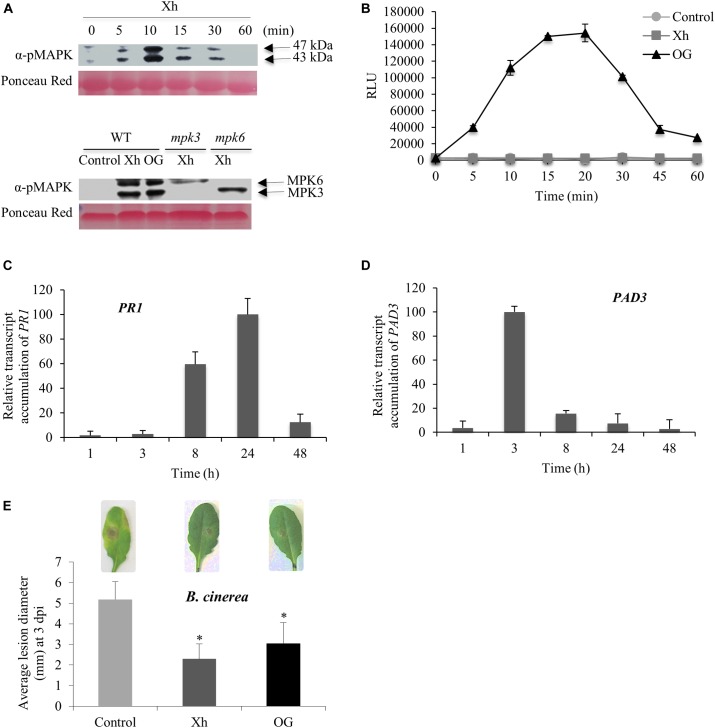
Immune responses and resistance against B. cinerea induced by Xh or OG in Arabidopsis. (A) Upper lane: phosphorylation of two mitogen-activated protein kinases (MAPKs) in Col-0 plants treated by Xh (1 mg/ml) detected by immunoblotting with α-pERK1/2. Lower lane: phosphorylation of two mitogen-activated protein kinases (MAPKs) in Col-0, mpk3 and mpk6 mutant plants treated by Xh (1 mg/ml) and detected at 10 min by immunoblotting with α-pERK1/2. Results are from one representative experiment out of three. (B) H2O2 production in Arabidopsis cells treated with water (control), Xh, or OG (1 mg/ml) detected by chemiluminescence using a luminol-peroxidase-based assay. Data represent means ± SD from one representative experiment out of three. (C,D) Time course of relative expression of defense genes encoding pathogenesis-related protein 1 (PR1) and phytoalexin deficient 3 (PAD3) after Xh treatment measured by qPCR. Results represent the mean ± SD of three biological replicates. Data were expressed as percentage of the Xh-treated Col-0, the strongest time point induction set as 100%. (E) Xh-induced resistance against B. cinerea in Arabidopsis. Two days after treatment by spraying with water (control), Xh (2.5 mg/ml), or OG (2.5 mg/ml), Col-0 plants were inoculated with B. cinerea (5.104 conidia ml-1) and disease symptoms were measured at 3 dpi. Results represent the mean lesion diameter ± SD of four independent experiments. Asterisks indicate statistically significant differences between control and elicitor-treated plants using a Student’s t-test (P < 0.05). A representative leaf for each treatment is shown.